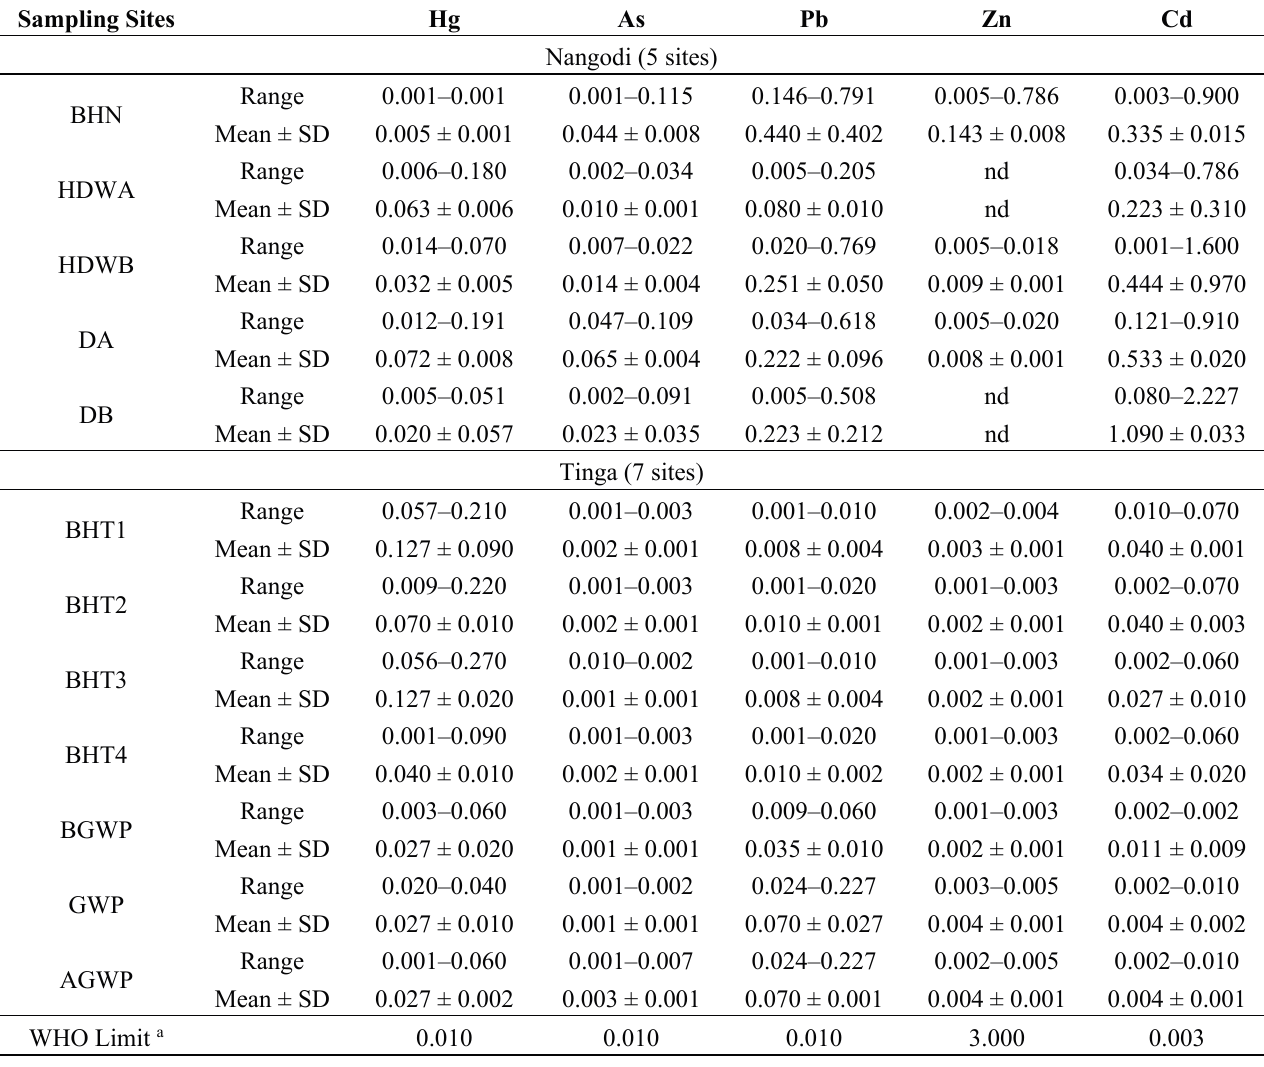
Table 3. Concentration (mg/L) of heavy metals in water samples from Nangodi and Tinga. Sampling